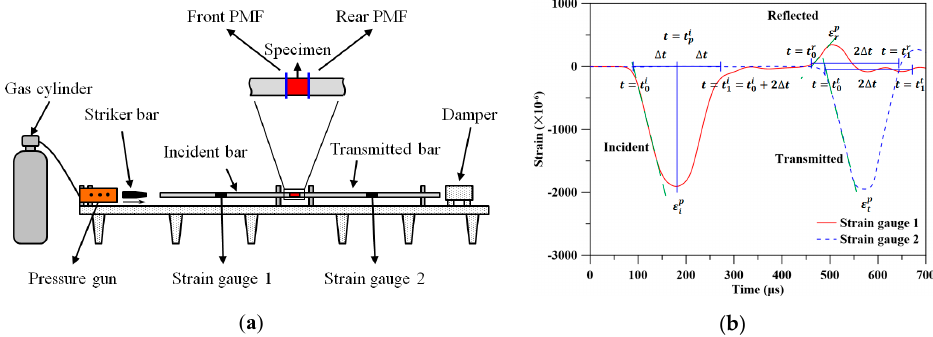
Figure 2. Setup of experiment with the Split Hopkinson Pressure Bar (SHPB) test ( a ) and interpretation on measured waveforms of strain histories ( b ).